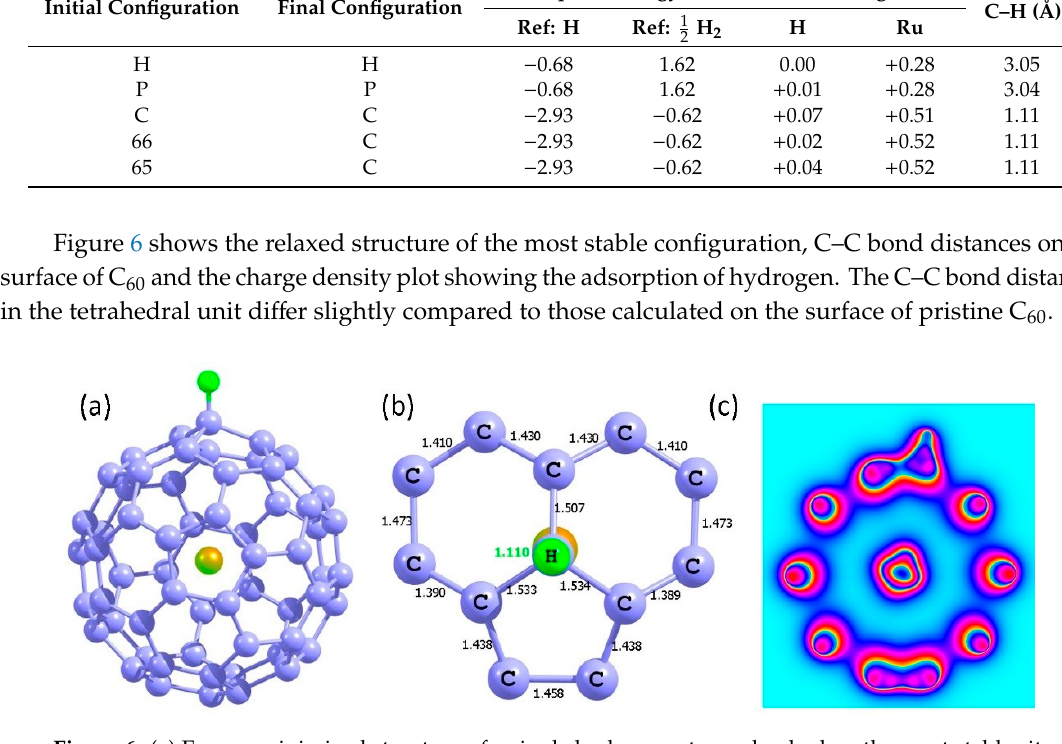
Figure 6. ( a ) Energy minimized structure of a single hydrogen atom adsorbed on the most stable site (C) of Ru@C 60 , ( b ) bond distances in the relaxed configuration and ( c ) charge density plot. Thereafter, the adsorptions of two hydrogen atoms were considered. As discussed earlier, three possible configurations were considered. The most favorable adsorption site is 66. As